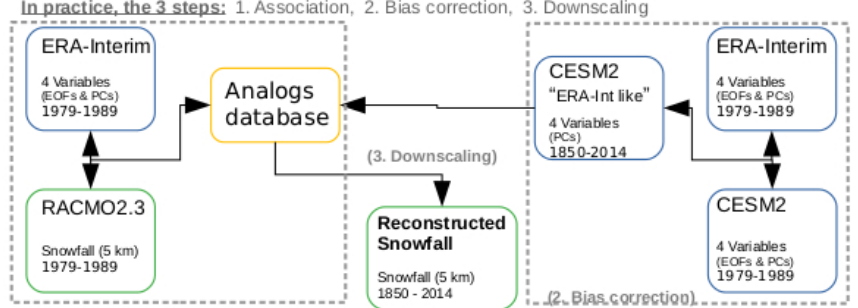
Figure 3. The analogs method follows three steps: (1) the building of the analogs database using the association of the reanalysis PCs to the snowfall accumulation from RACMO2.3, (2) the transformation of CESM2 into “reanalysis-like” fields, (3) the search in the analogs database. The second step ensures the compatibility of the principal components between the database and the